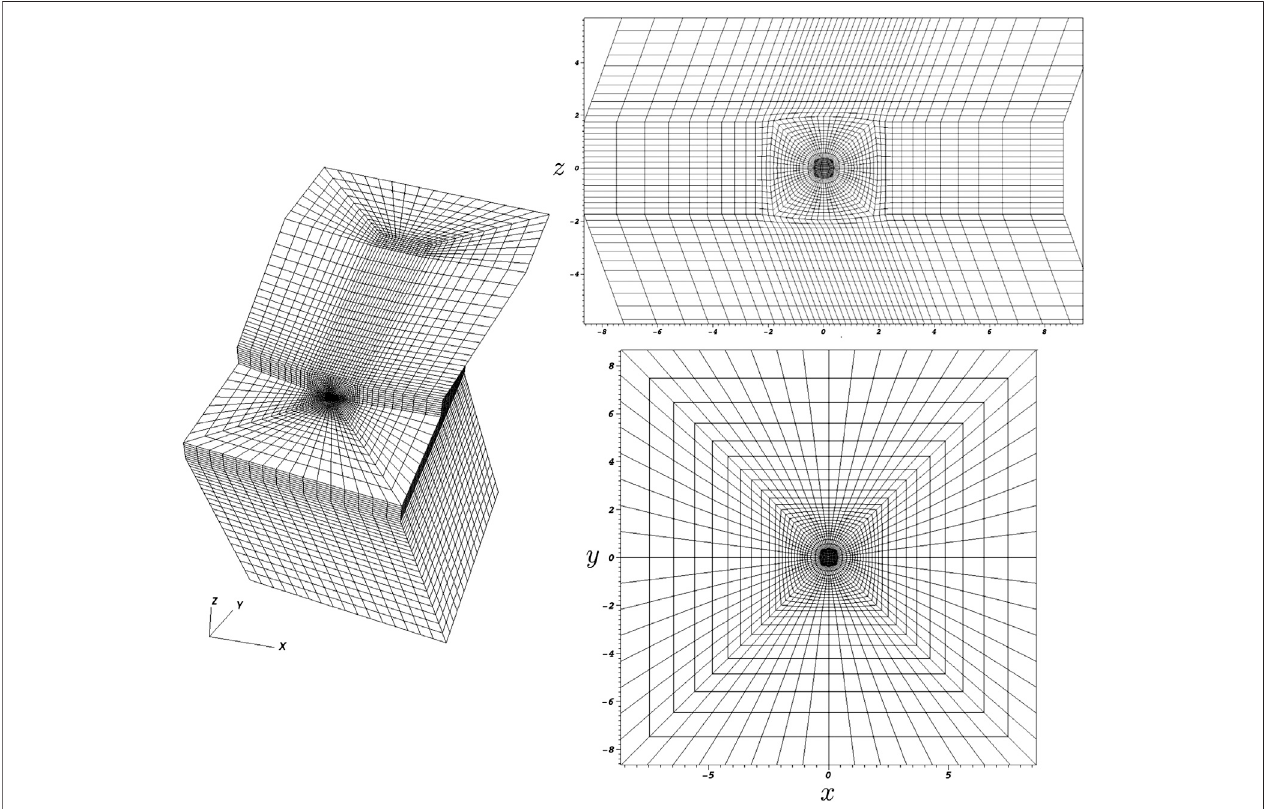
FIGURE 4 | ComputationalmeshfortheAlvénwingtestproblembuiltfrom14,336curvedelements.Attheorigintheelementsarecurvedtocapturethesphericalshapeofthe neutralgascloud U .Duetothegeometric fl exibilityoftheDGSEMthemeshinthenorthernandsouthernregionsaretitledinordertocapturetheAlvénwingstructuresmoreaccurately.